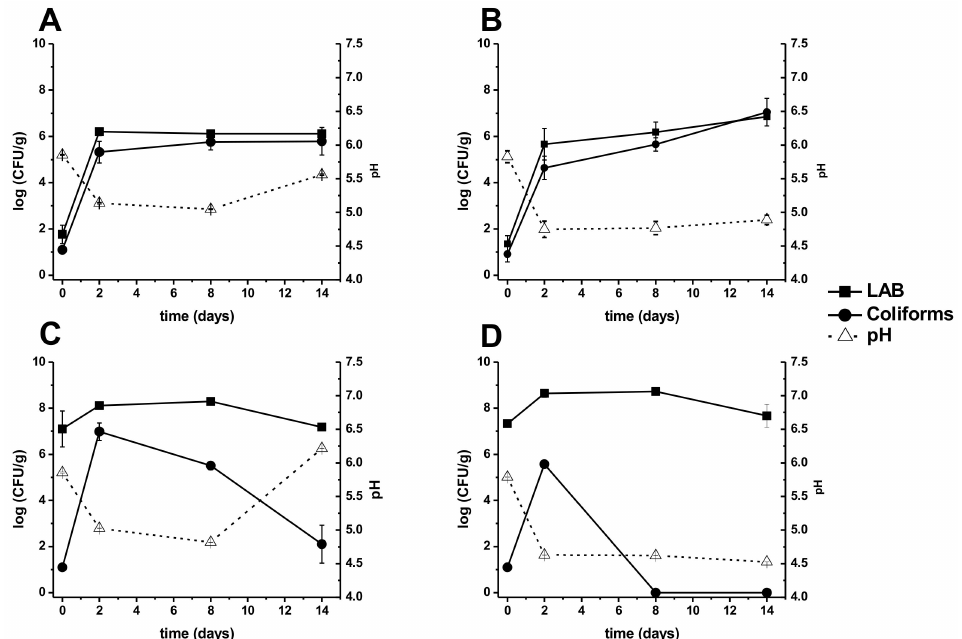
Figure 1. Microbiological and pH analyses: ( A ) acid whey fish (AwF); ( B ) acid whey fish molasses (AwFM); ( C ) acid whey fish lactic acid bacteria Lr (AwFLr); ( D ) acid whey fish molasses lactic acid bacteria Lr (AwFMLr). Filled squares represent lactic acid bacteria (LAB); filled circle represents coliforms; open triangles represent the pH. Error bars represent the standard deviation of three independent